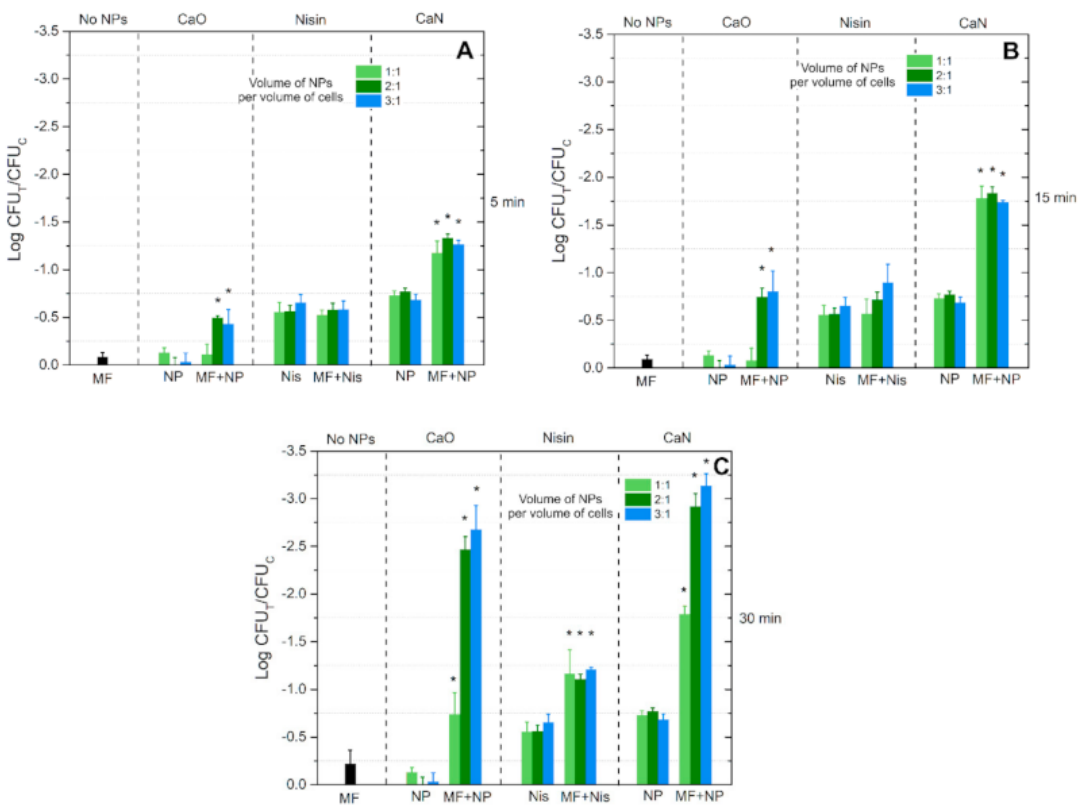
Figure 8. The viability response of L. innocua to high alternating magnetic field (125 mT, 200 kHz) and activated nisin-loaded (CaN), nisin-free (CaO) magnetic nanoparticles or nisin-only solution (Nisin). ( A ) After 5 min exposure; ( B ) 15 min exposure and ( C ) 30 min exposure. In all cases the treatment (CFU T ) is normalized to untreated control samples (CFU C ). Asterisk (*) corresponds to statistically significant difference ( p < 0.05) versus NP-only or nisin-only